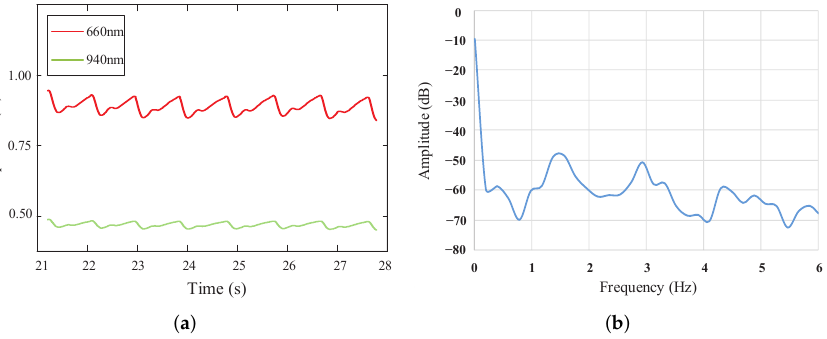
Figure 15. ( a ) Recorded PPG waveforms from 660 nm and 940 nm wavelengths lights. ( b ) The spectrum of 660 nm red light PPG